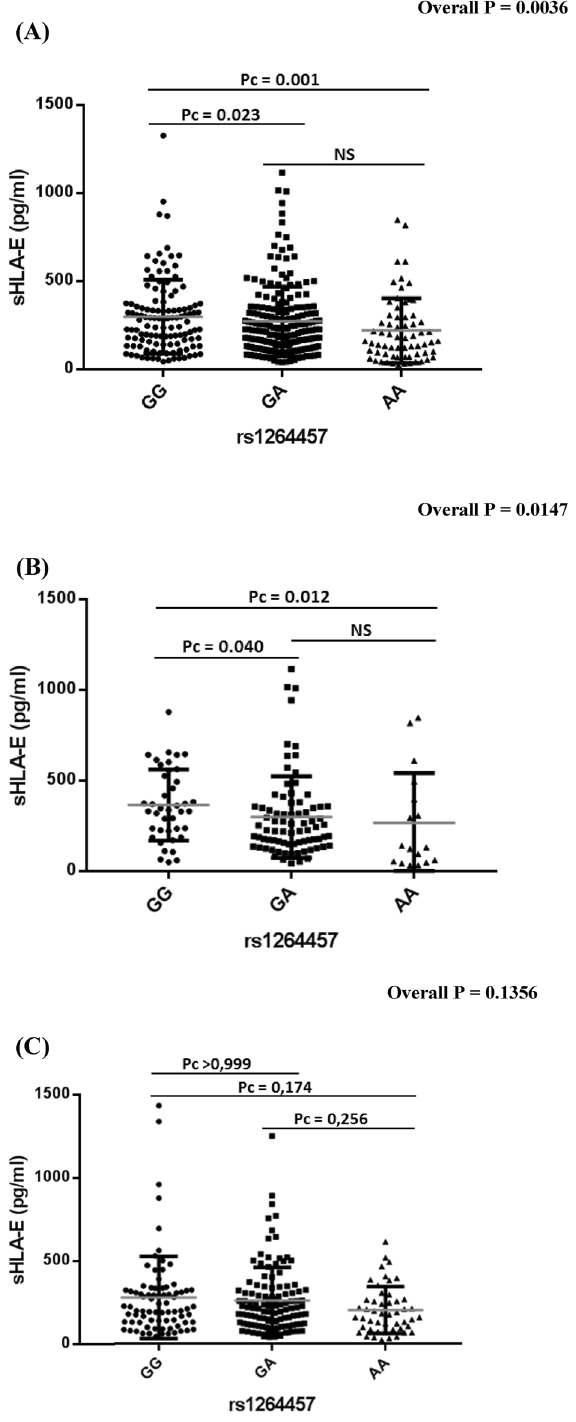
Figure 4. Analysis of sHLA-E levels according to the genetic distribution of the HLA-E rs 1264457 AA, AG and GG genotypes in the whole cohort of patients and in the subgroup of SZ patients. ( A ) In the whole cohort of patients including SZ and BD, sHLA-E levels increase in a linear manner along HLA-E genotypes (AA = 218.5, AG = 270.27, GG = 315.28, overall p = 0.0036). ( B ) In patients with SZ, sHLA-E levels are also observed to increase along HLA-E genotypes (AA = 265.65, AG = 298, GG = 364.58, overall p = 0.0147). ( C ) In patients with BD, no difference was observed concerned the distribution of sHLA-E according to the HLA-E rs 1264457 AA, AG and GG genotypes (AA = 202.1, AG = 259.9, GG = 277.1, overall p = 0.1356). All figures were generated using GraphPad Prism version 7.00 for Windows, GraphPad Software, La Jolla California USA, www. graph pad.